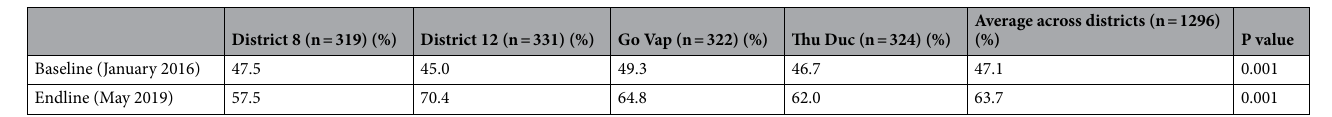
Table 2. Client awareness of hypertension status by district at baseline and